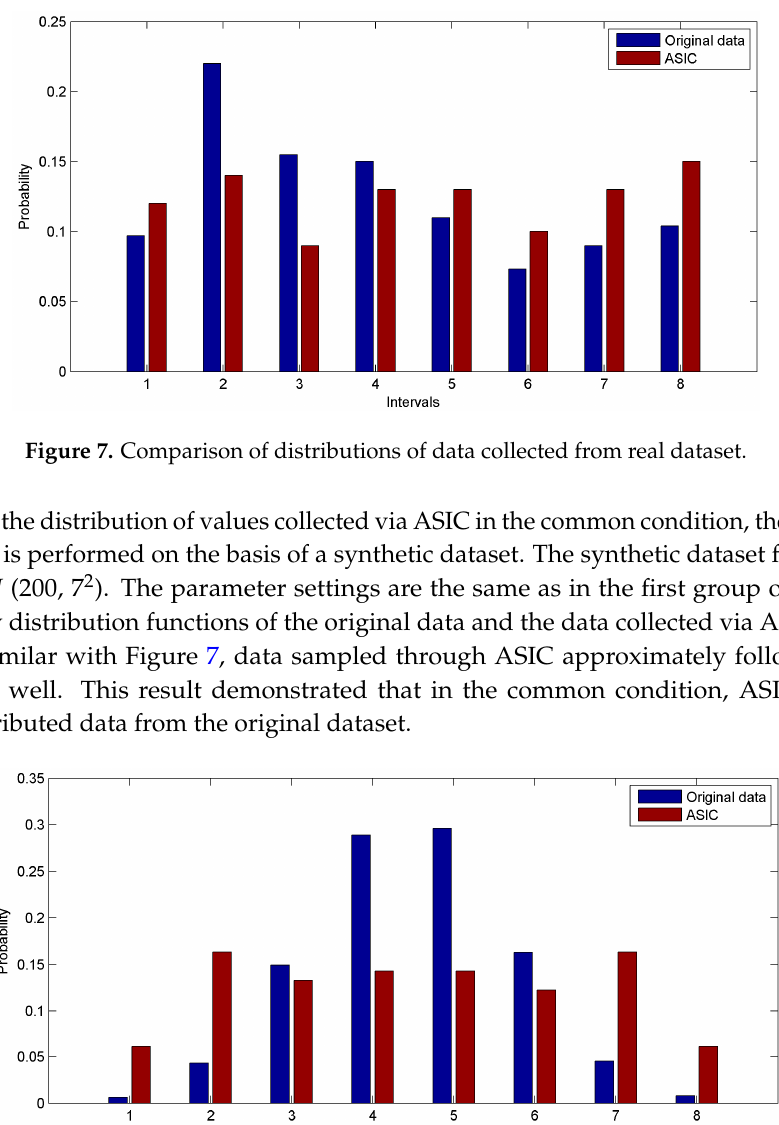
Figure 6. Effects of number of bins.